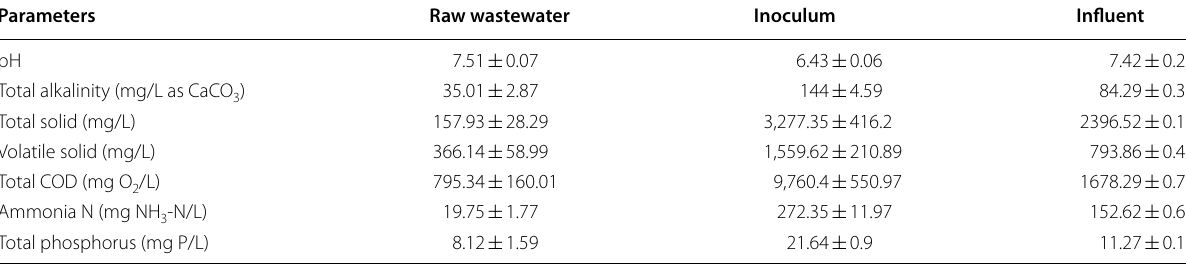
The value indicates means